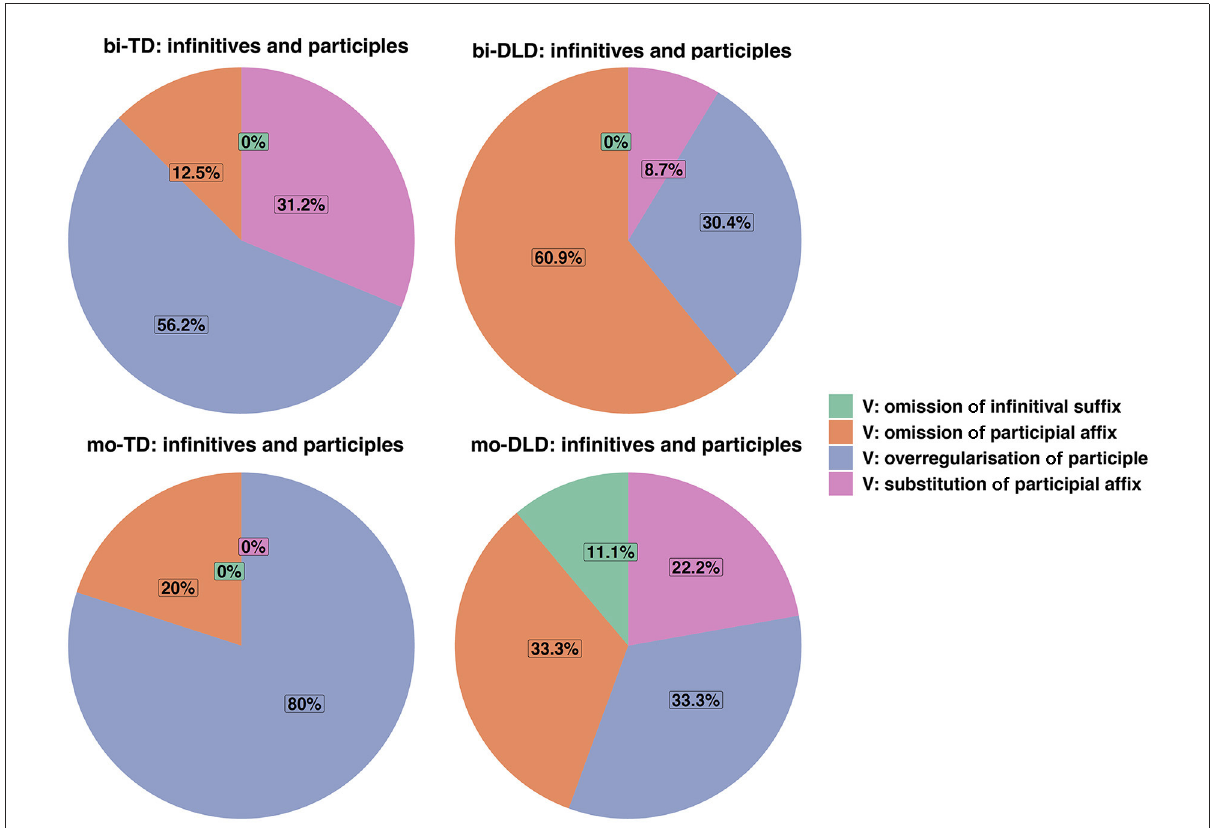
FIGURE8 Distributions of infinitives and participles in Dutch in the bi-TD, bi-DLD, mo-TD, and mo-DLD